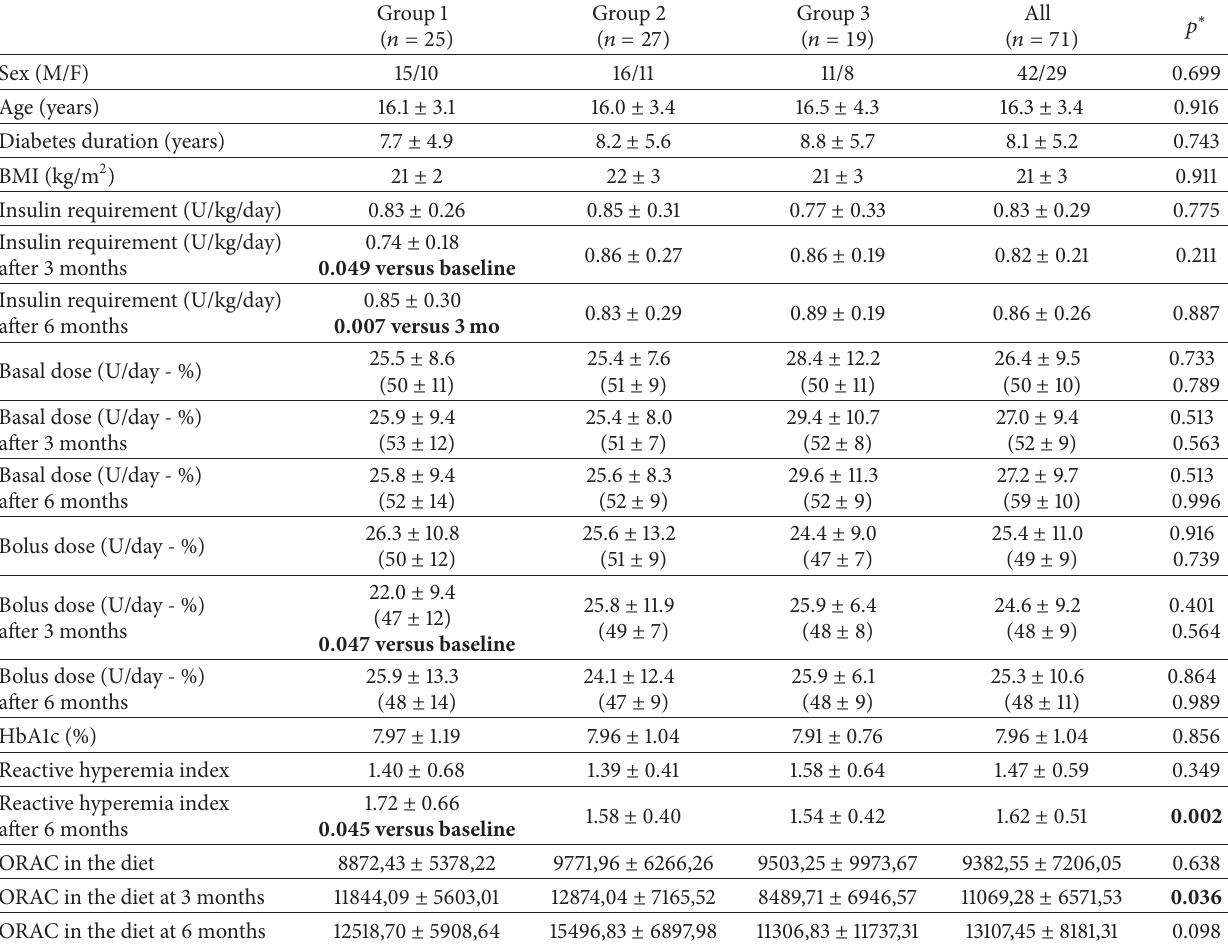
Table 1: Clinical characteristics of the three study groups at baseline and after 3 and 6 months of follow-up.